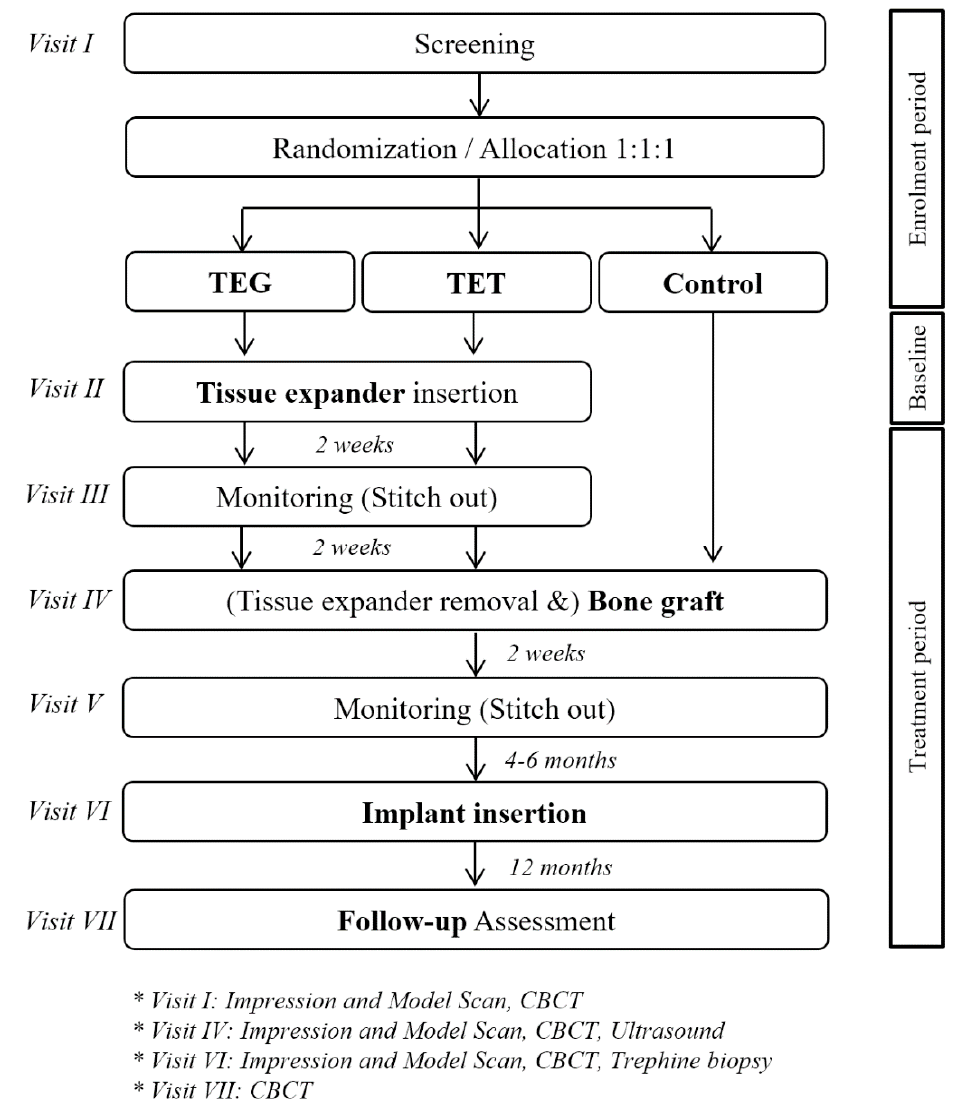
Figure 1. Timeline and schematic of study design and protocol. CBCT: cone beam computed tomography.